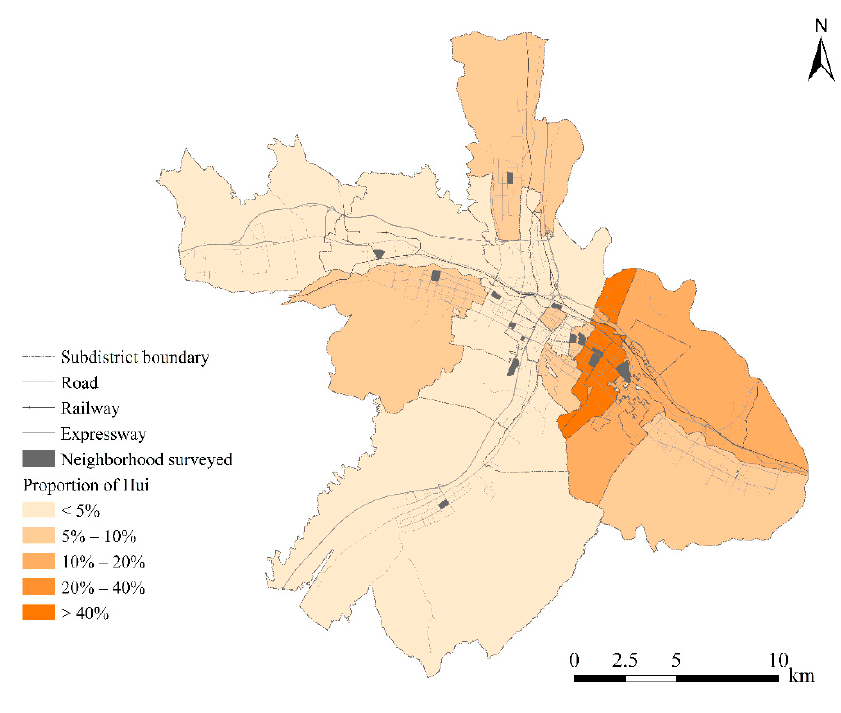
Figure 2. The study area.